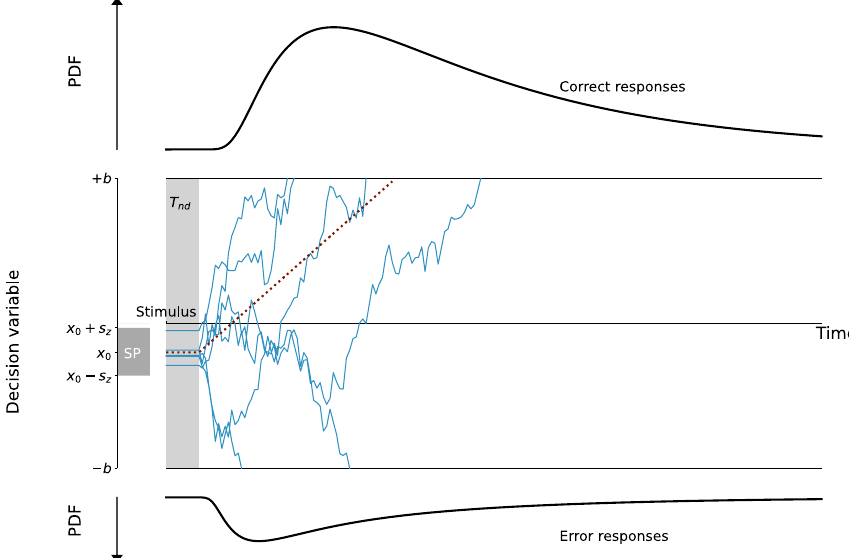
Figure 5. Description of the Drift-Diffusion model (DDM). The decision state is represented through a decision variable that travels from a starting point that can be drawn for example from a uniform distribution, centered around x 0 and of width 2 s z . The decision state is represented through a decision variable x traveling from a starting point (for example, drawn from a uniform distribution, centered around x 0 and of width 2 s z . It is represented as “SP” on the figure) to a boundary (“Correct boundary” or “Incorrect boundary”) under the influence of a constant drift (dotted line). The trajectory is also impacted by white noise so that real trajectories are similar to the thin blue lines. From the stimulus onset, the decision process is delayed by a certain non- decision time ( T nd ). Over an ensemble of decisions, RT distributions of correct and error responses can be estimated, as displayed